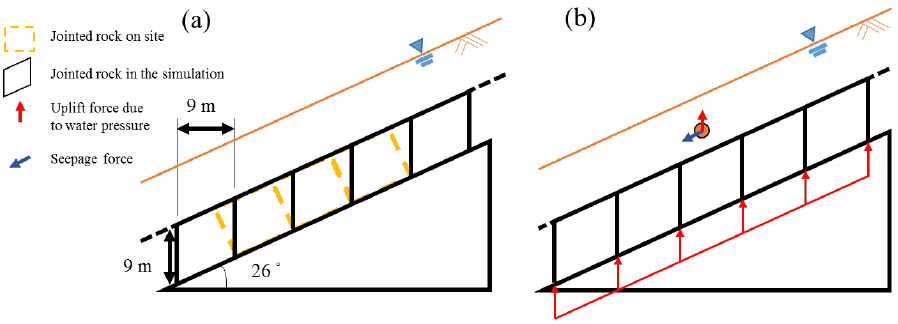
Figure 9. Schematics of ( a ) the digital model; ( b ) water pressure settings.